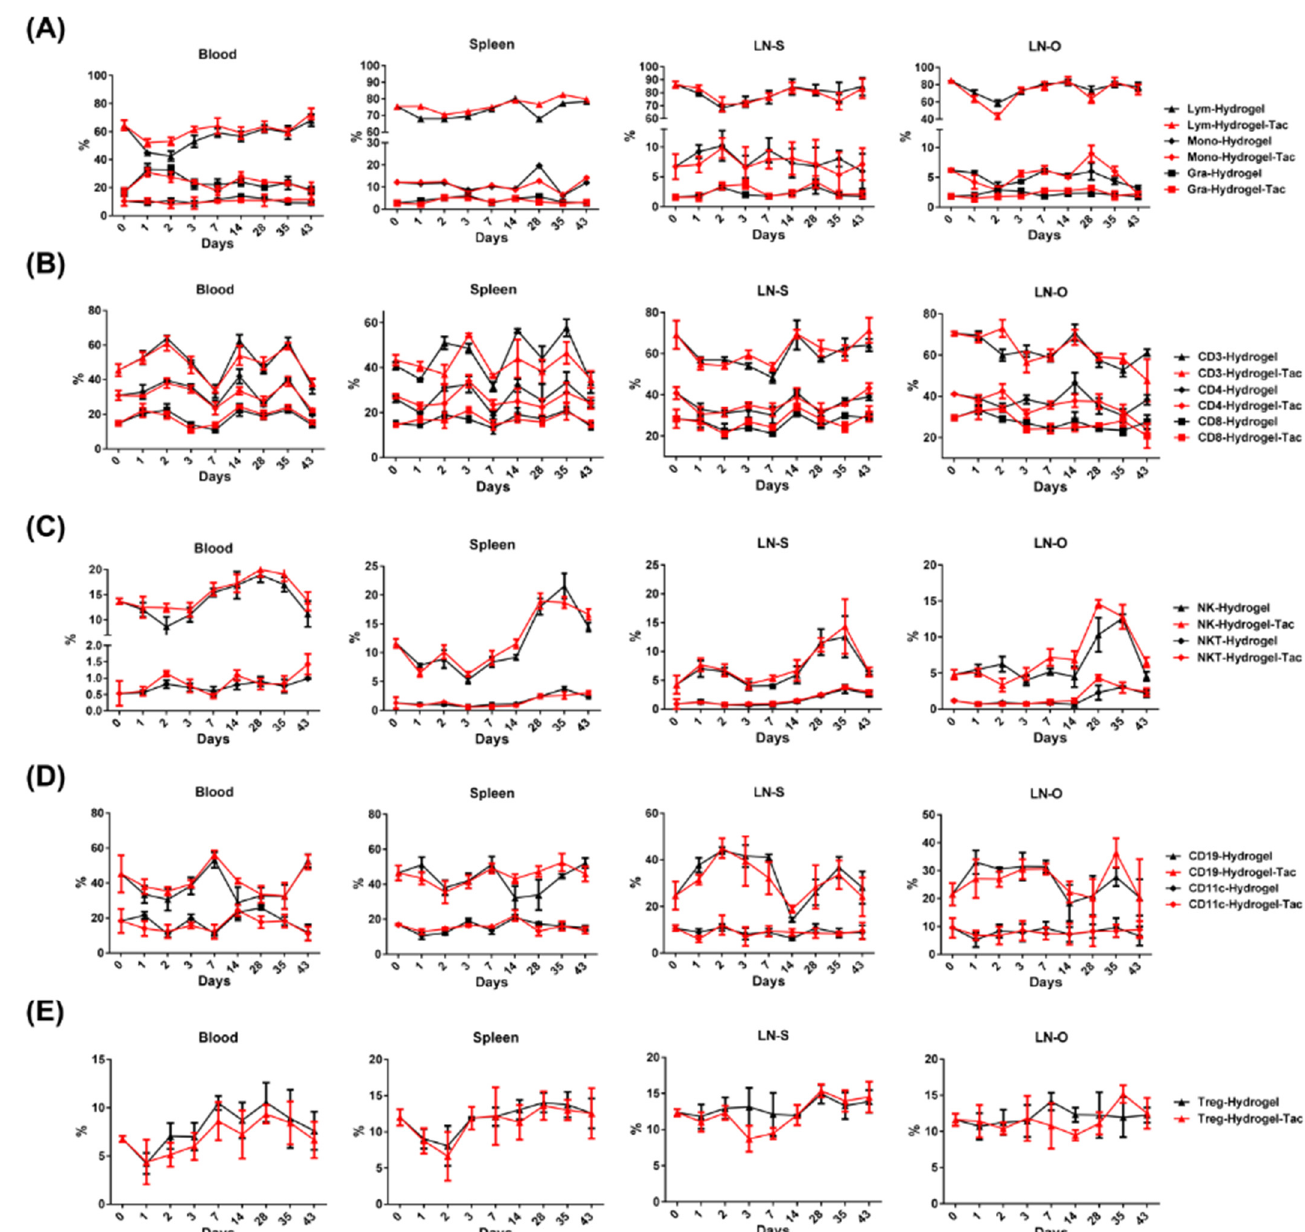
Figure 2. The effects of Hydrogel-Tac local injection on the systemic immune system. At different time points, various lymphoid organs, such as blood, spleen, and LNs, were harvested from the mice treated with one subcutaneous injection of 0.1 mL of hydrogel or Hydrogel-Tac (2 mg/mL) and then analyzed by flow cytometry. LN-S refers to the LNs on the same side as the hydrogel injection and near the right hindlimb. LN-O refers to the LNs on the opposite side to the hydrogel injection and near the left hindlimb. ( A ) Lymphocyte, monocyte, and granulocyte subsets were analyzed between the hydrogel and Hydrogel-Tac groups. ( B ) CD3 + , CD4 + , and CD8 + T-cell subsets were examined between both groups. ( C ) Natural killer (NK1.1 + , NK) and natural killer T (NK1.1 + CD3 + , NKT) cell subsets were determined between both groups. ( D ) CD19 + B and CD11c + dendritic cell subsets were verified between both groups. ( E ) CD4 + CD25 + FoxP3 + regulatory T (Treg) cell subset was evaluated between both groups. Each group had three mice. Mean ± SD was used to represent the statistical data.